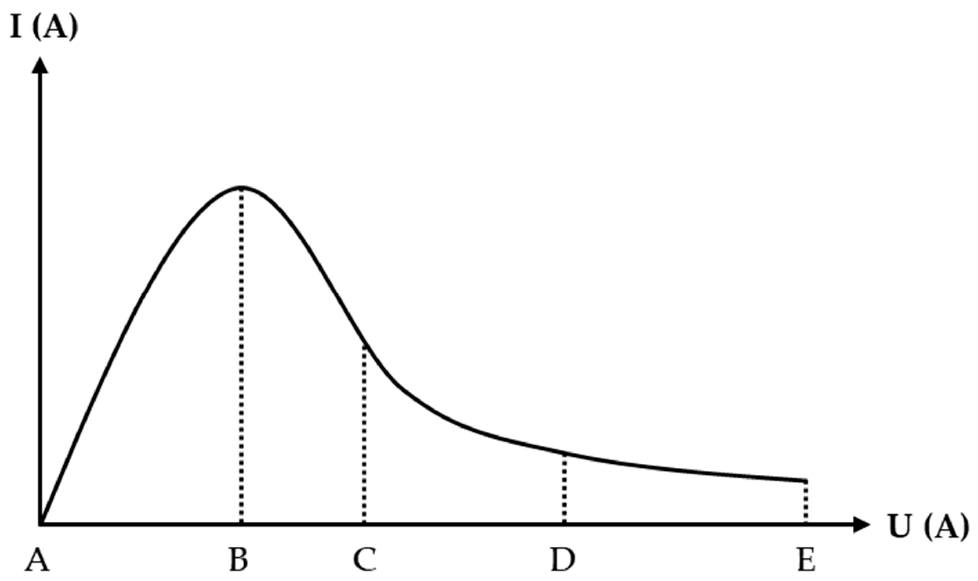
Figure 1. Current–voltage characteristics of the PEP anode process [5].